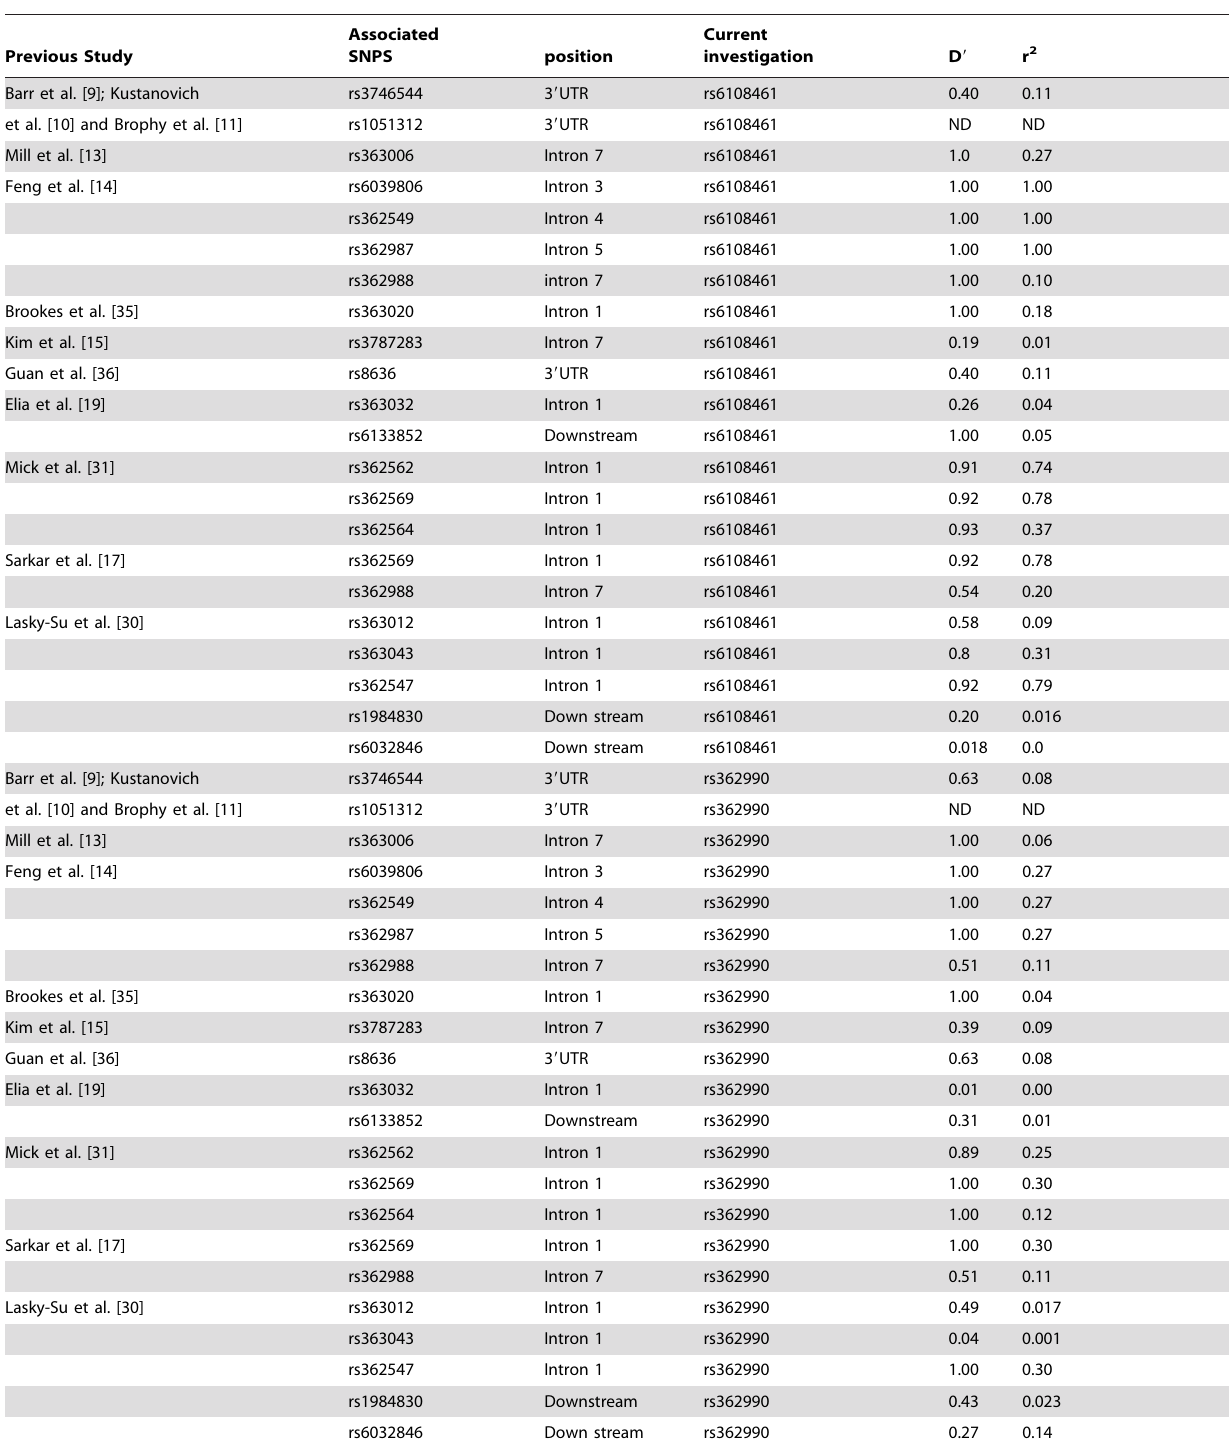
Table 3. Linkage disequilibrium relation of previously associated ADHD- SNAP25 variants with SNPs of this